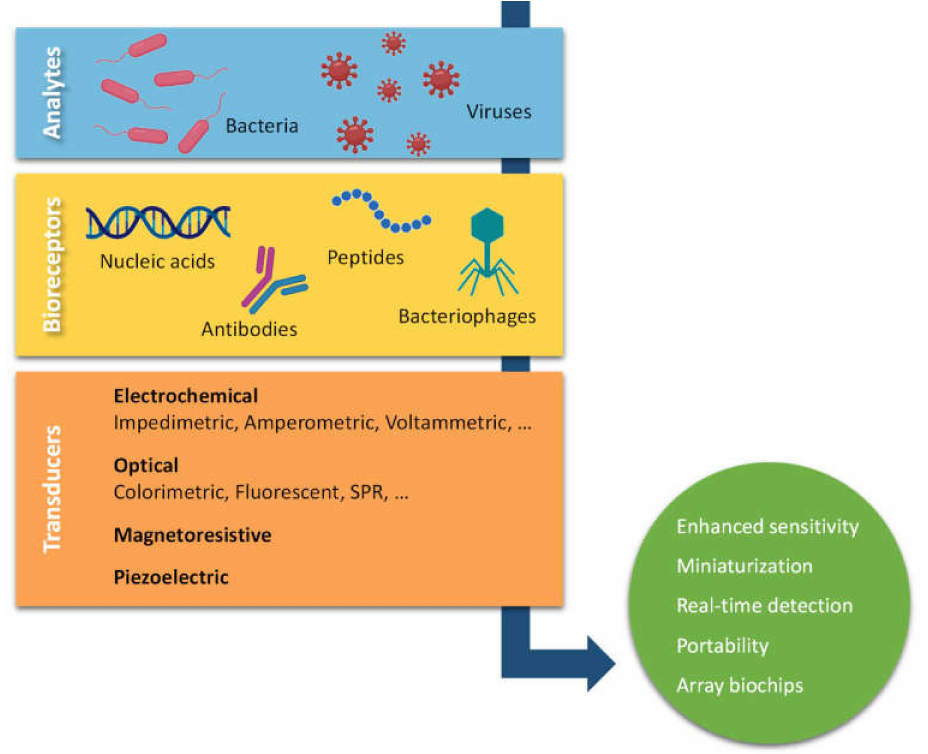
Figure 2. Schematic representation of common biosensors for improved detection of zoonotic